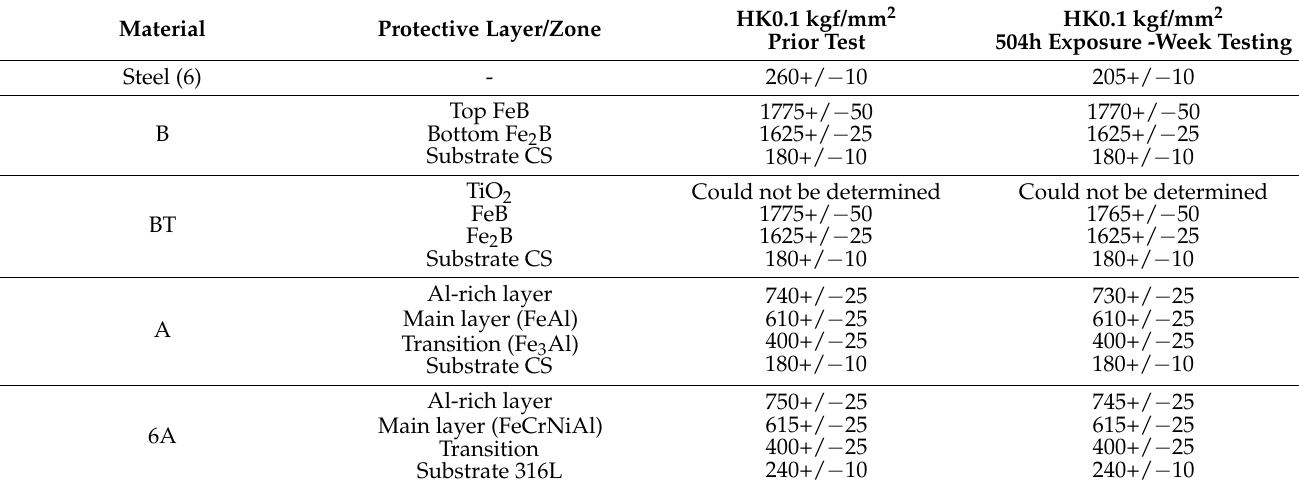
Table 5. Micro-hardness data (HK0.1) of the studied